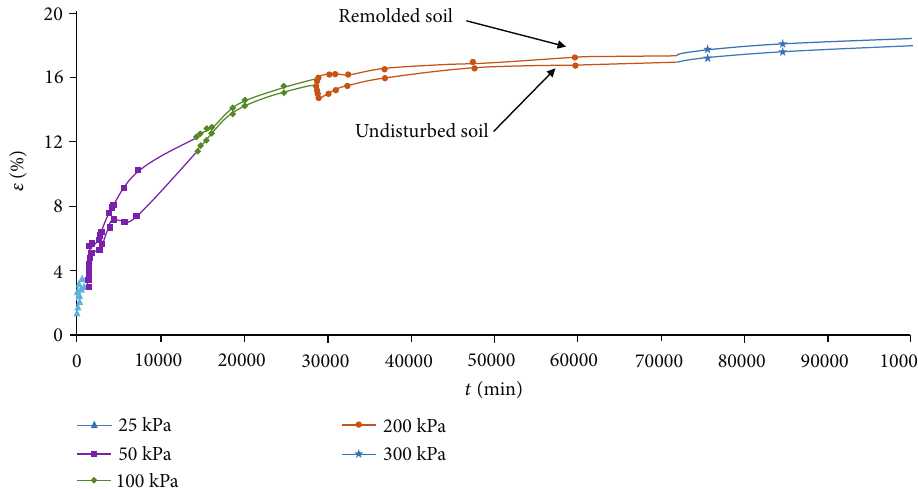
Figure 10: Strain-time curves of undisturbed and reconstituted soil